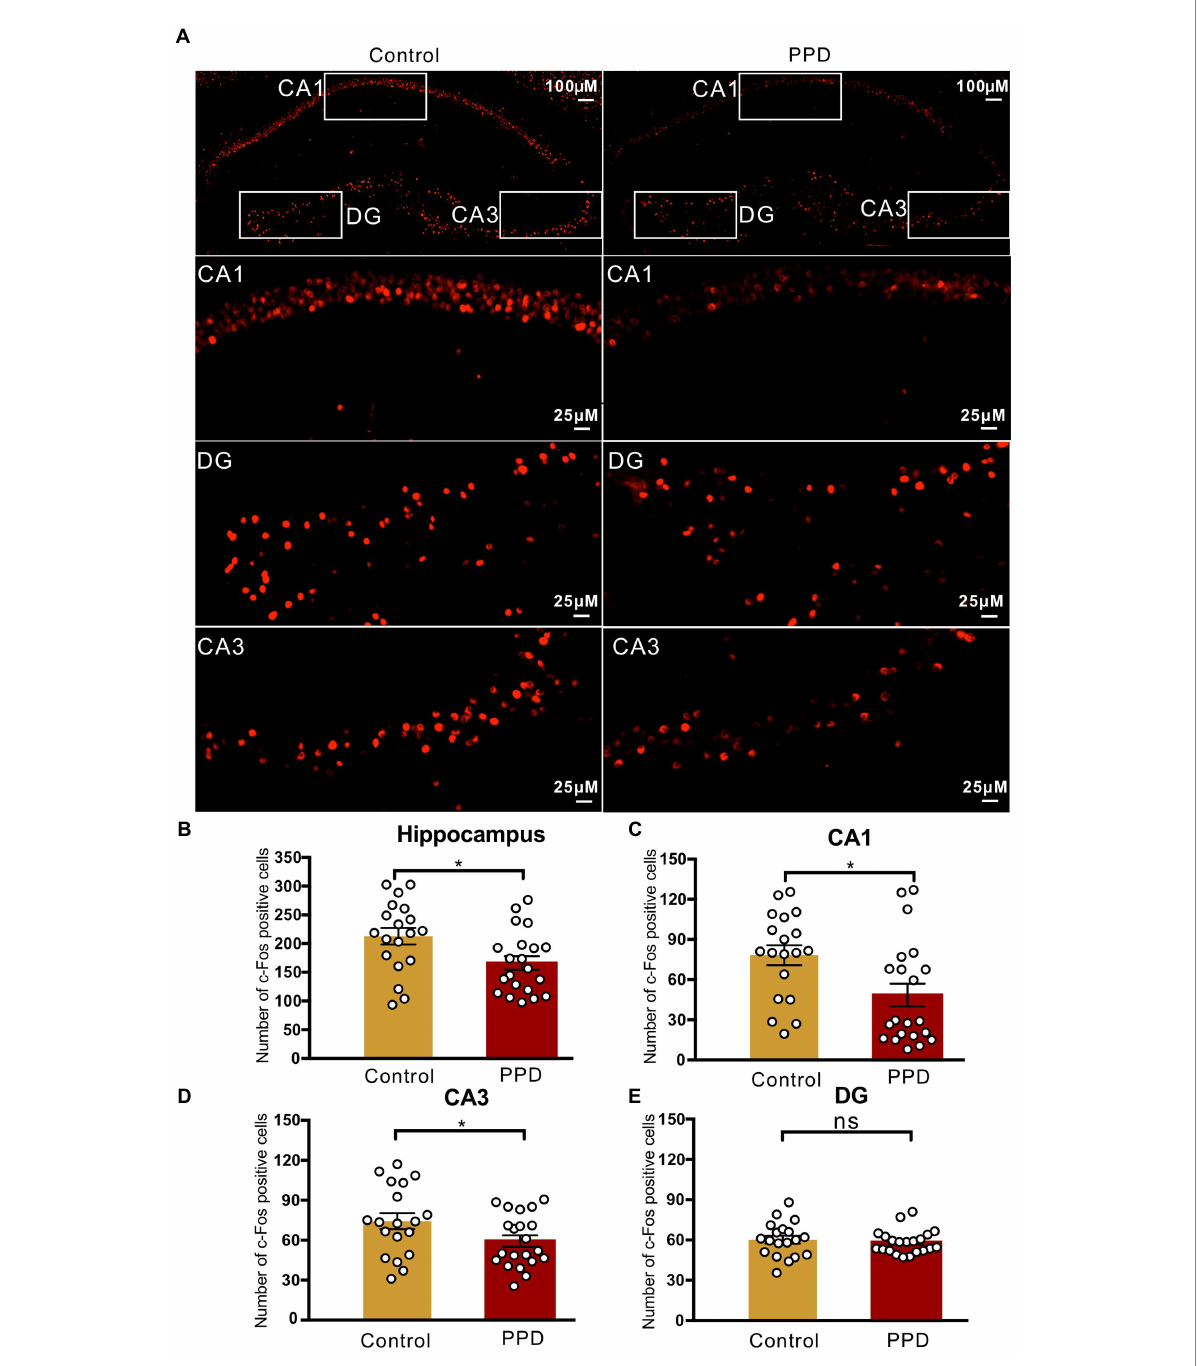
FIGURE 3 c-Fos positive cells in the hippocampus. (A) Representative images of c-Fos (red) positive cells in the hippocampus. (B) The number of c-Fos positive cells in the hippocampus. (C–E) The number of c-Fos positive cells in the subregions of the CA1 (C) , CA3 (D) , and DG (E) . Data were mean ± SEM. White circles represent individual data points. * p < 0.05 vs. Con; ns, not significant (unpaired t -test). CA, cornu ammonis; DG, dentate